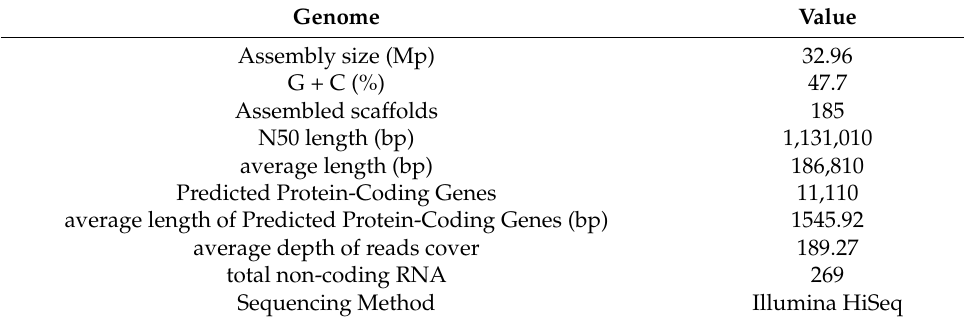
Table 1. General features of the B9